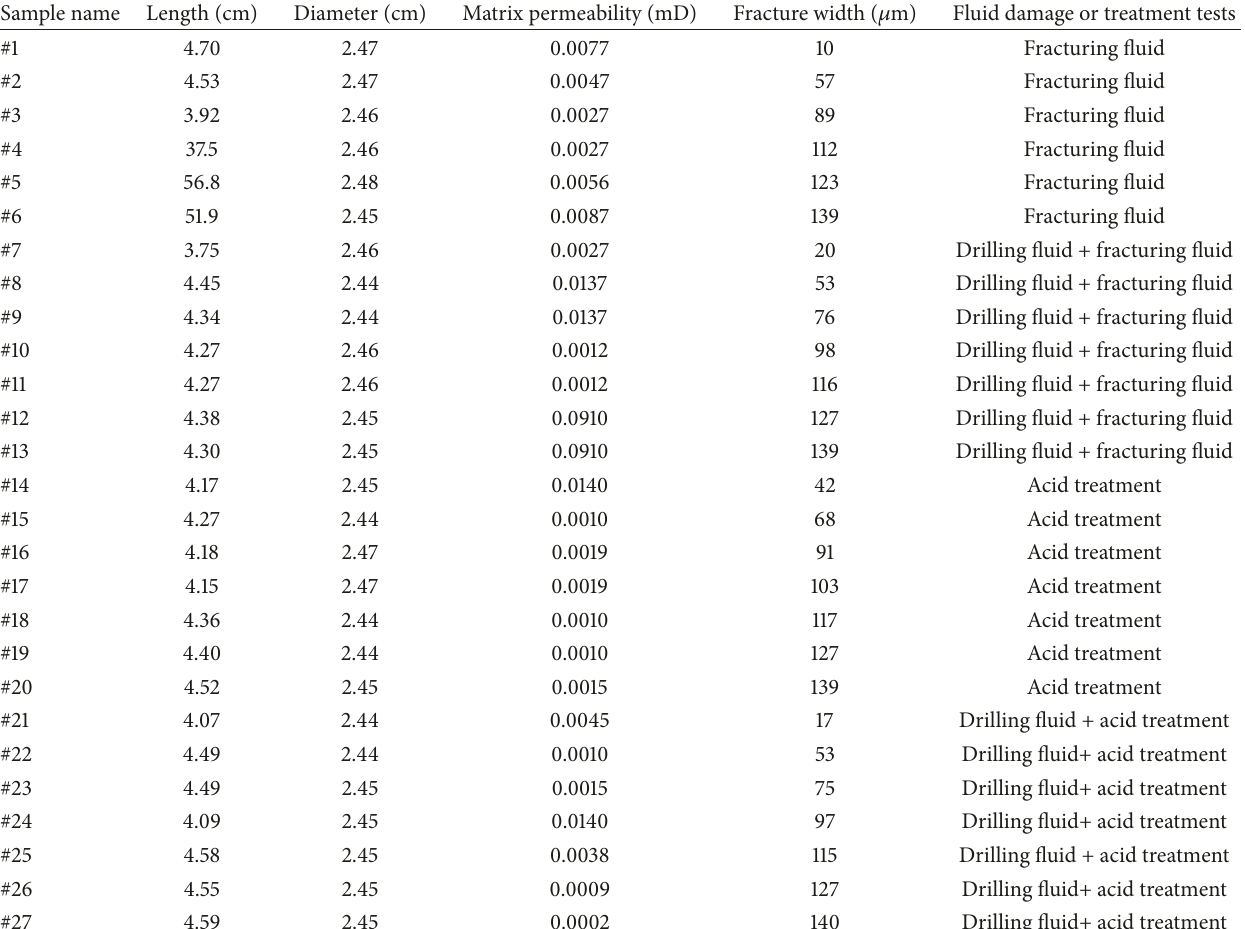
Table 1: Information about core samples used in this